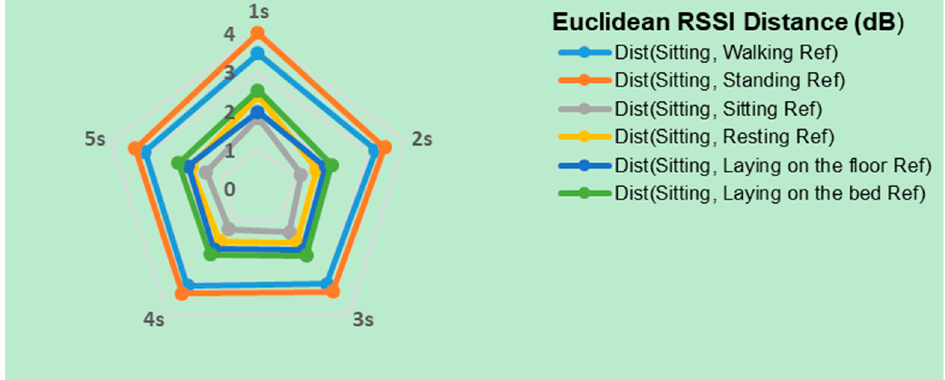
Figure 6. System performance for sitting position over a stipulated timeframe.